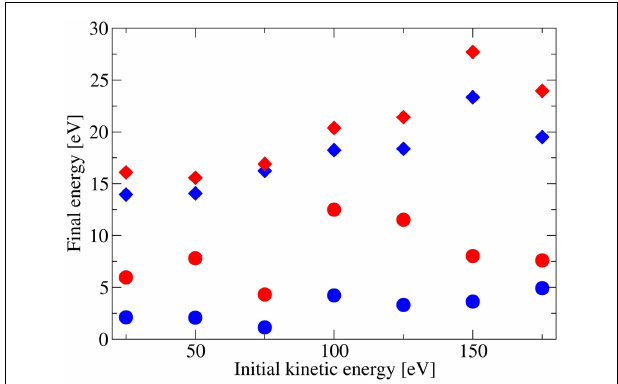
FIGURE 5 | Fullerene total internal kinetic energies after bouncing back from the Si(111) 7 (cid:2) 7 surface at room temperature (blue diamonds) and 500°C (red diamonds) as a function of the initial C 60 kinetic energy . Furthermore, we show the center of mass kinetic energies for both 20°C (blue circles) and 500°C (red circles) substrate temperatures.